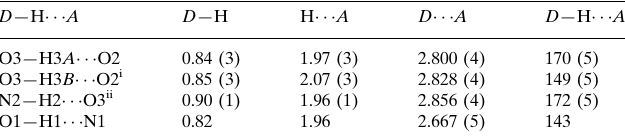
Hydrogen-bond geometry (A˚ , (cid:2)